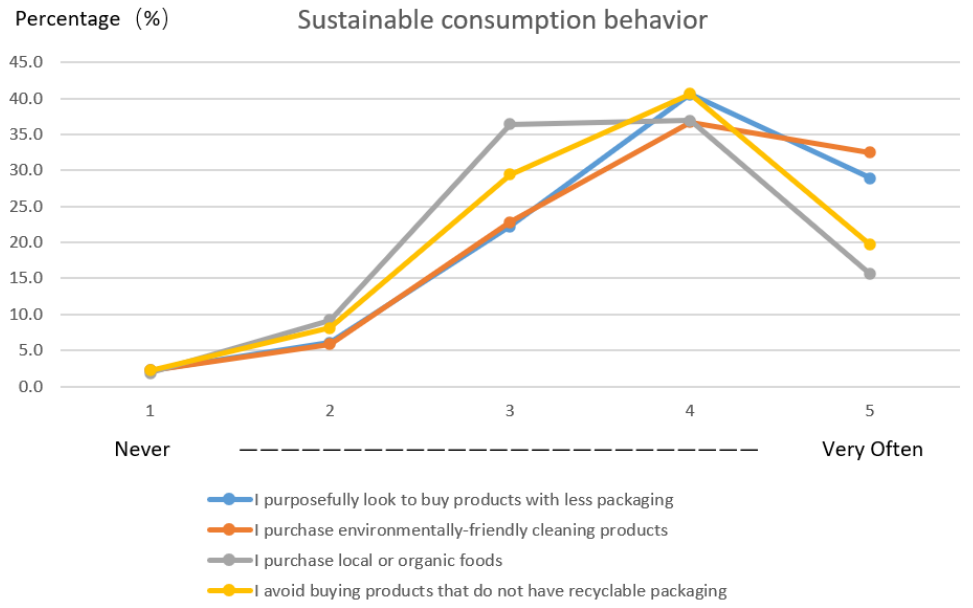
Figure 1. Frequency of response to sustainable consumption behaviour.